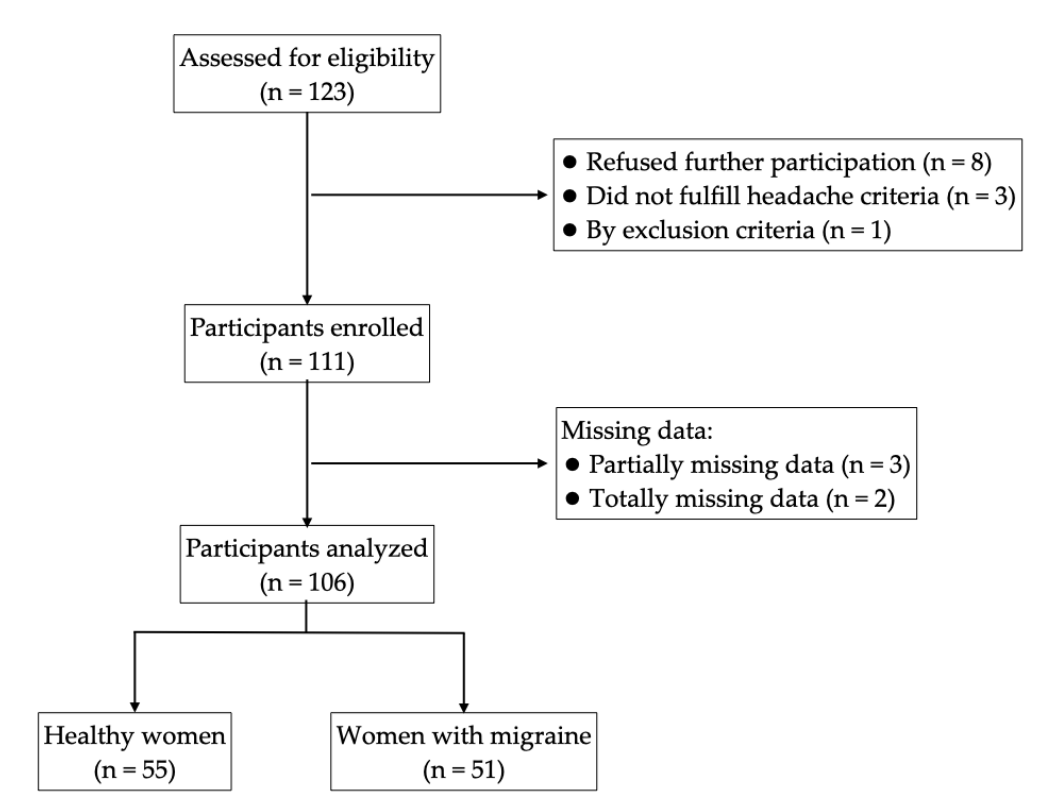
Figure 1. Flowchart of participant selection for the study.